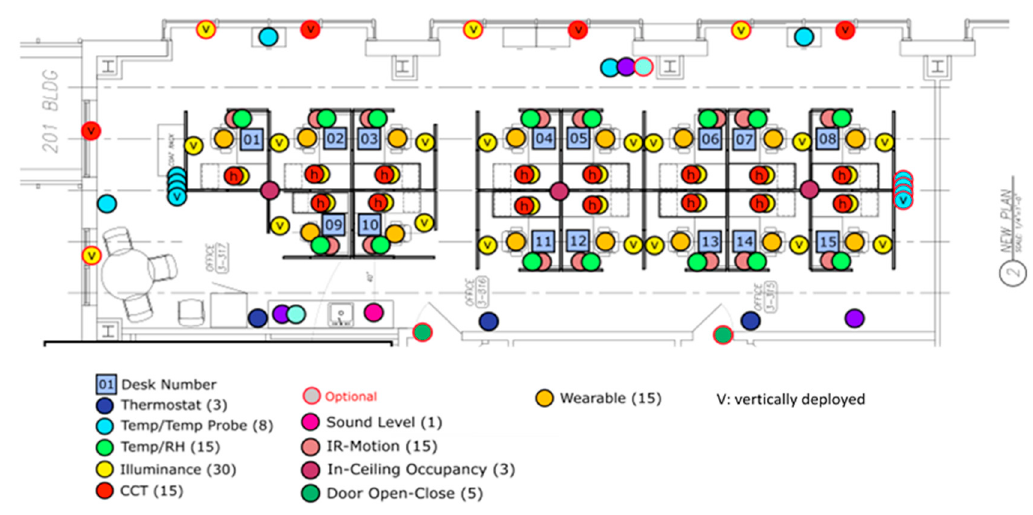
Figure 5. Sensor deployment for environmental measurement.